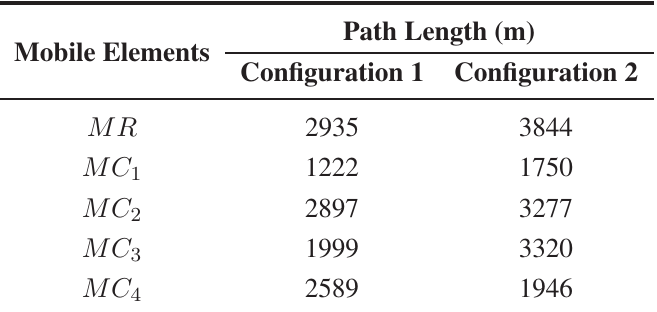
Table 1. Path length configurations.